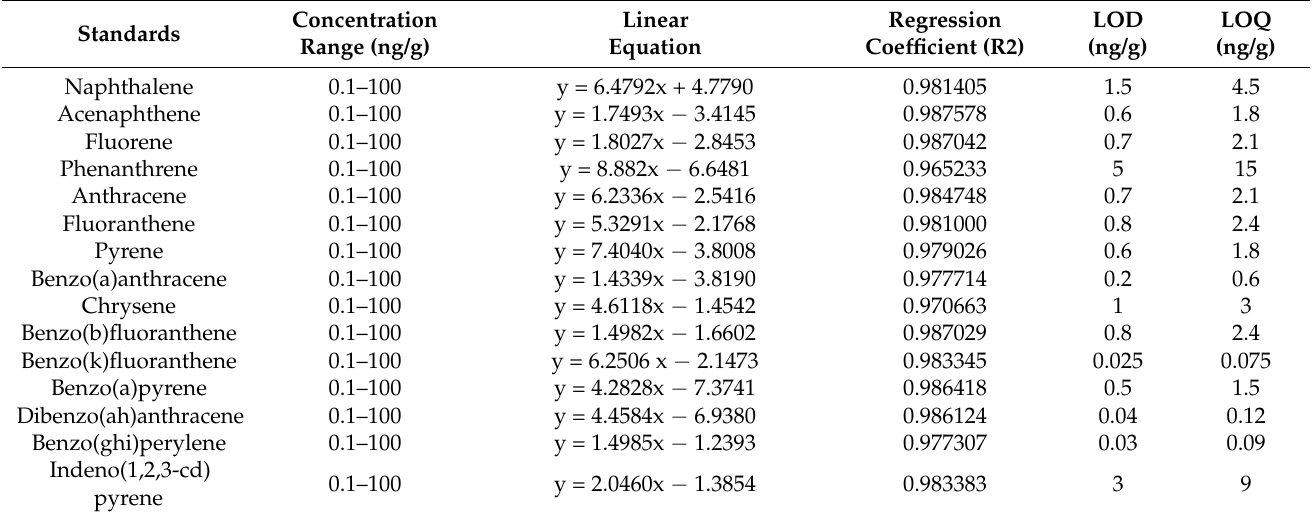
Table 2. Linear equations, coefficients of regression, limit of detection (LOD) and quantification (LOQ) obtained for quantification of